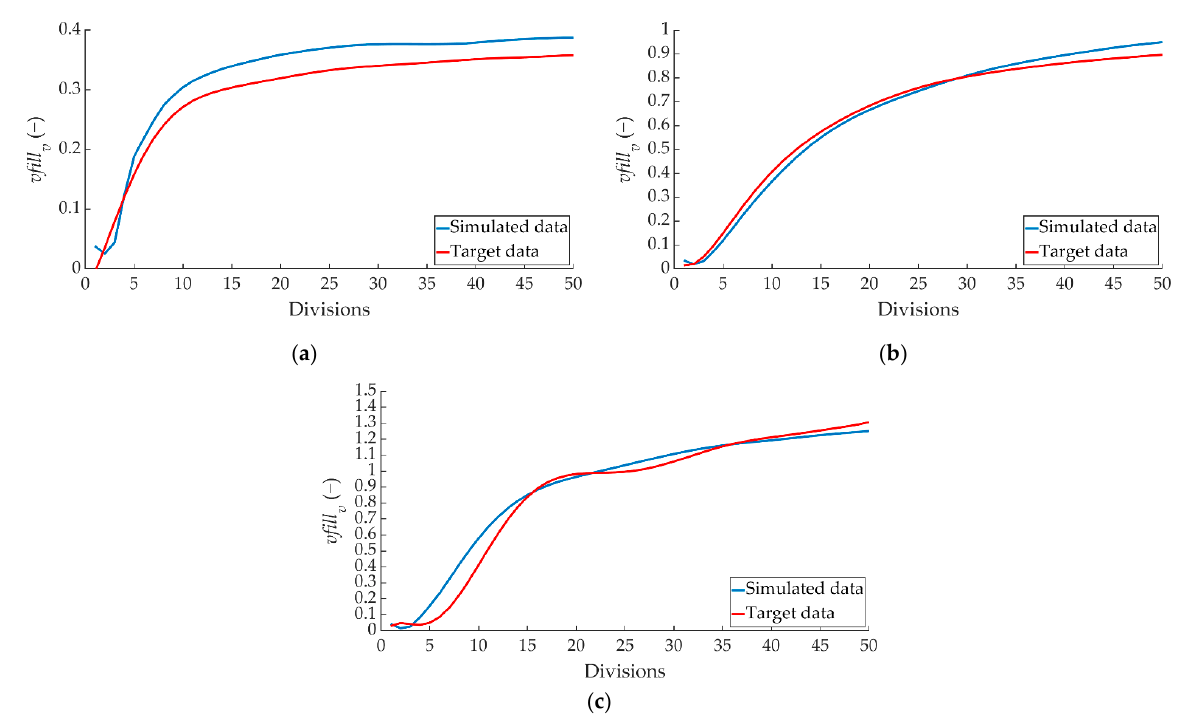
Figure 20. Comparison between the ANN-simulated data and vfill t target data for the two pressure sensors for braking at a speed of 70 km/h for the type: ( a ) maintained, ( b ) progressive and ( c ) emer- gency. Figure 21 shows the comparison between the ANN-simulated data and the target data for how the right pressure sensor achieves braking capacity as a function of braking time ( vfill v ).